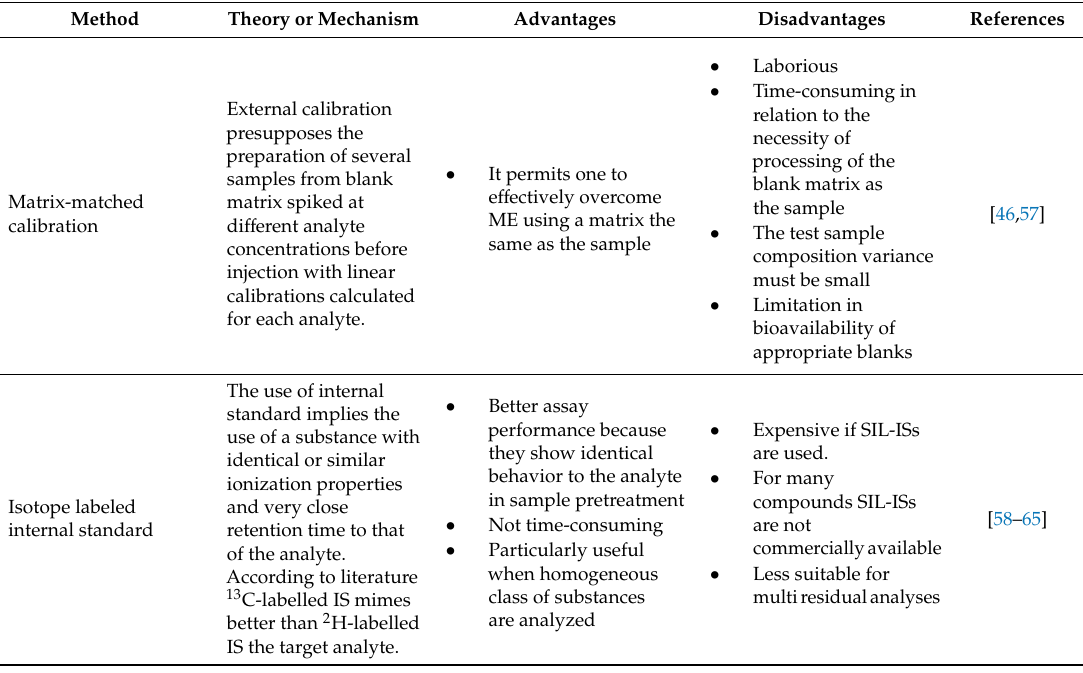
Table 2. Calibration approaches applied when the blank matrix is